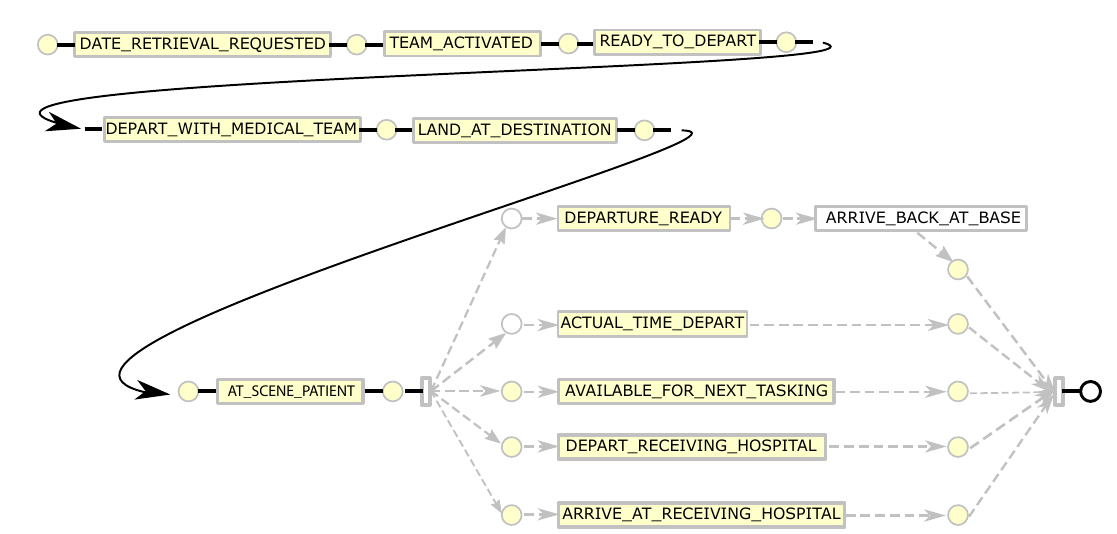
Figure 12. RSQ conformance model derived from sample